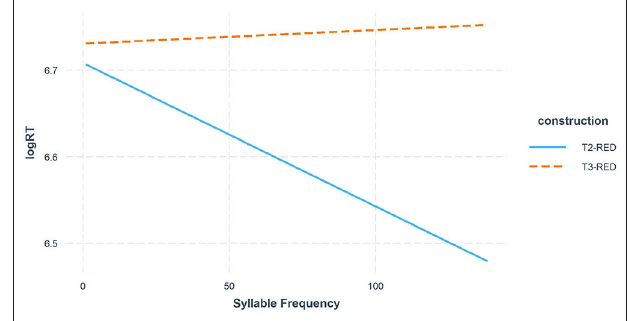
FIGURE 3 | Syllable Frequency effect in T2-RED vs. T3-RED